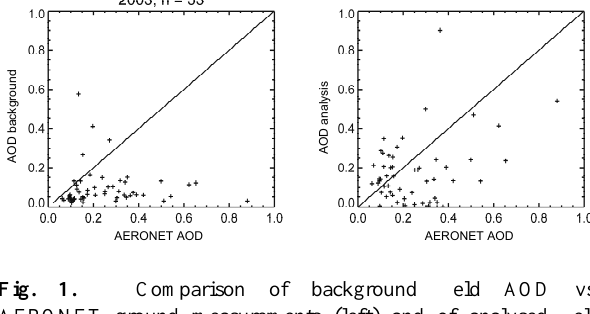
Fig. 1. Comparison of background field AOD vs. AERONET ground measurements (left) and of analysed field AOD vs. AERONET (right) for 53 coincidences with a minimum analysis increment of 0.05 during the study period July–November 2003 in Europe.